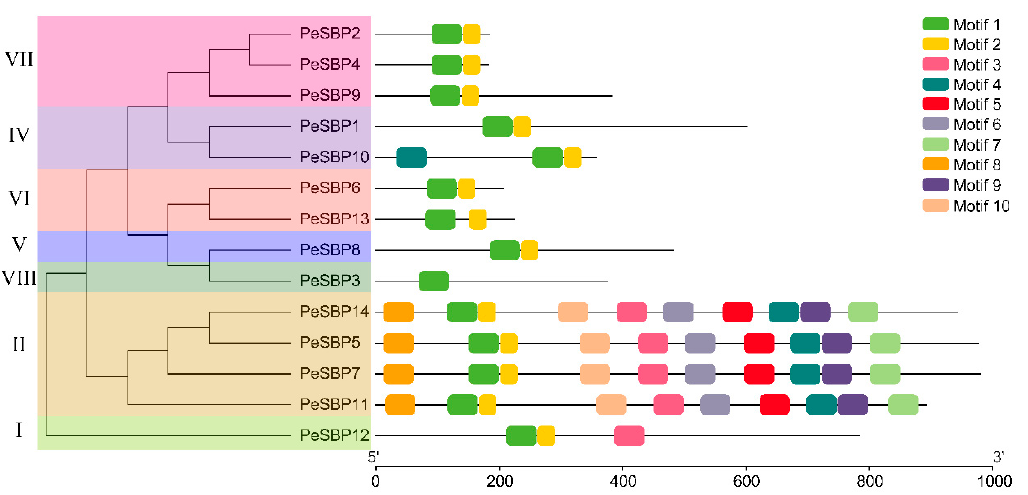
Figure 5. Distribution of the conserved motifs in passion fruit SBP proteins. Ten identified conserved motifs are marked in different colored